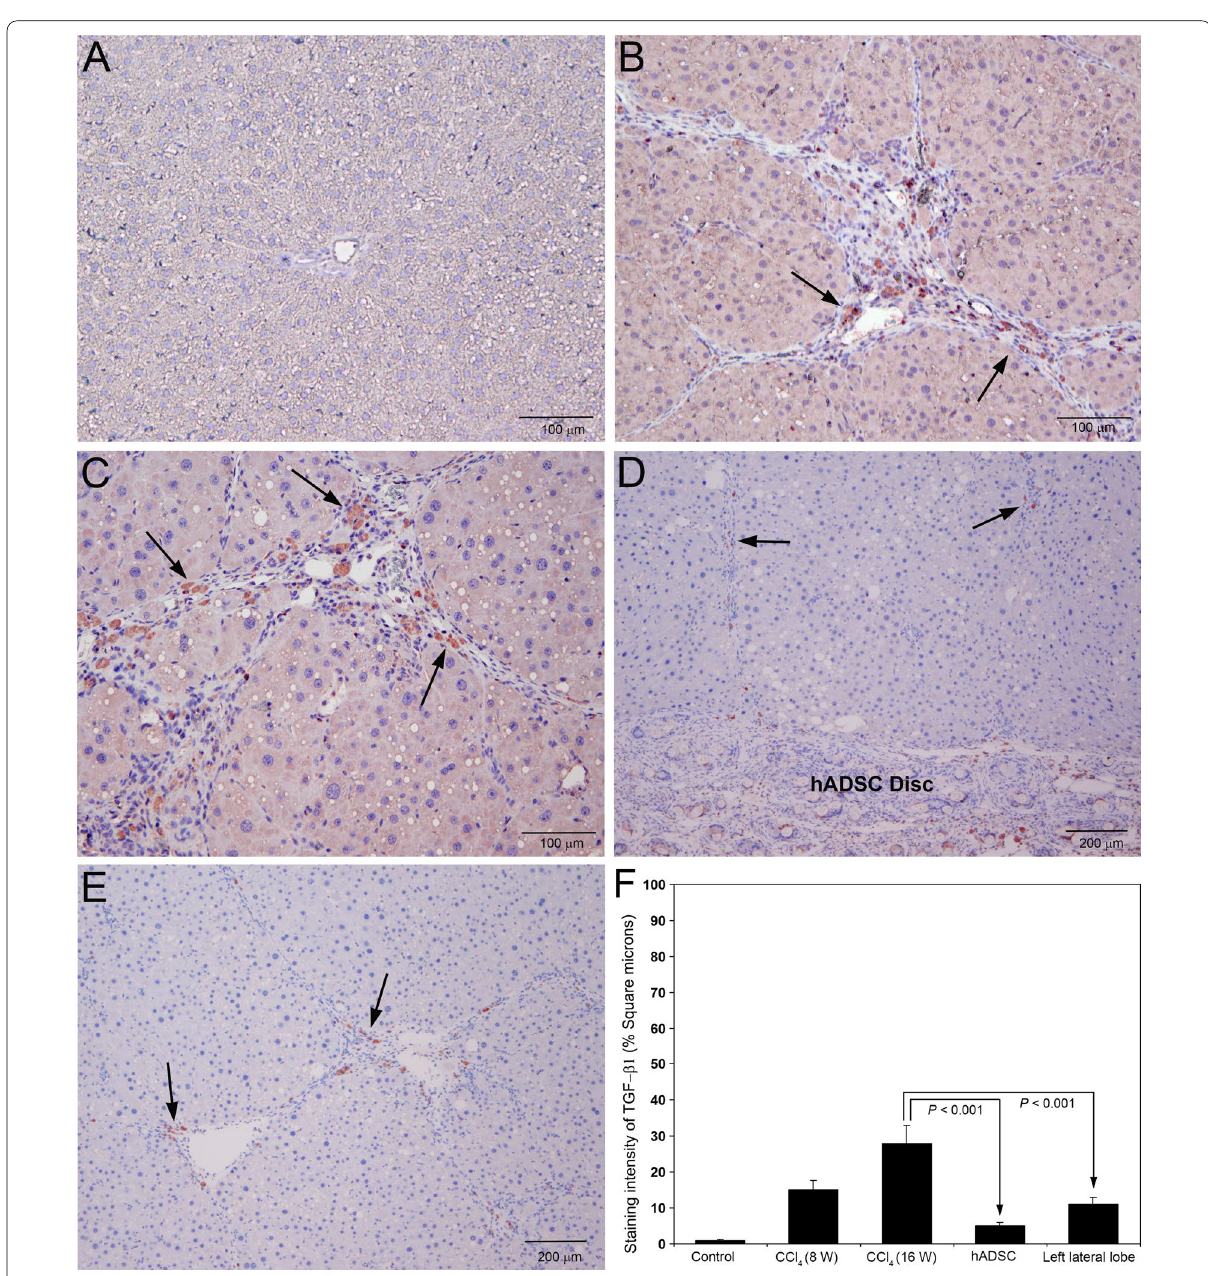
Fig. 5 Immunohistochemical staining for transforming growth factor-β1 (TGF-β1) in rat liver sections following serial administrations of CCl 4 and after treatment with hADSC disc. A Staining for TGF-β1 was completely absent in the control livers treated with olive oil for 16 weeks. B Marked staining for TGF-β1 was present in the fibrotic areas of rat livers treated with CCl 4 for 8 weeks (arrows). C Prominent and conspicuous staining for TGF-β1 was present at 16th week of CCl 4 administration, especially in the fibrotic zone (arrows). D Treatment with hADSC disc for 8 weeks showed marked reduction in staining for TGF-β1 in the hepatic parenchyma (arrows). The implanted hADSC disc is visible at the bottom portion of the image with positive staining for TGF-β1. E There was significant decrease in staining of TGF-β1 in the left lateral lobe, where the right lateral lobe is implanted with hADSC disc (arrows). A – C Original magnification, 100. D , E Original magnification, 40. F The staining intensity of TGF-β1 was × × quantified using Image-Pro Discovery software. The data are mean S.D. of 10 randomly selected microscopic fields from five rats per ±